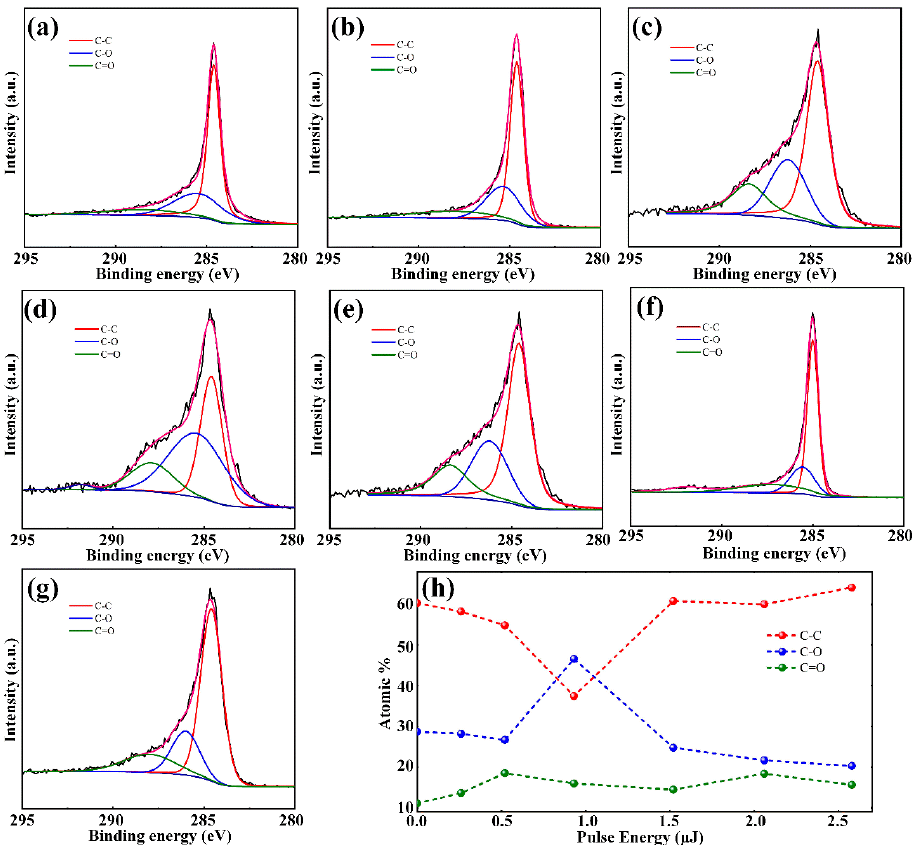
Figure 7. C 1s XPS spectra of the sample at different laser pulse ( a ) untreated graphite surface; ( b ) 0.26 µ J; ( c ) 0.52 µ J; ( d ) 0.93 µ J; ( e ) 1.52 µ J; ( f ) 2.06 µ J; ( g ) 2.58 µ J. ( h ) Comparison of the contents of three functional groups changing with pulse energy.